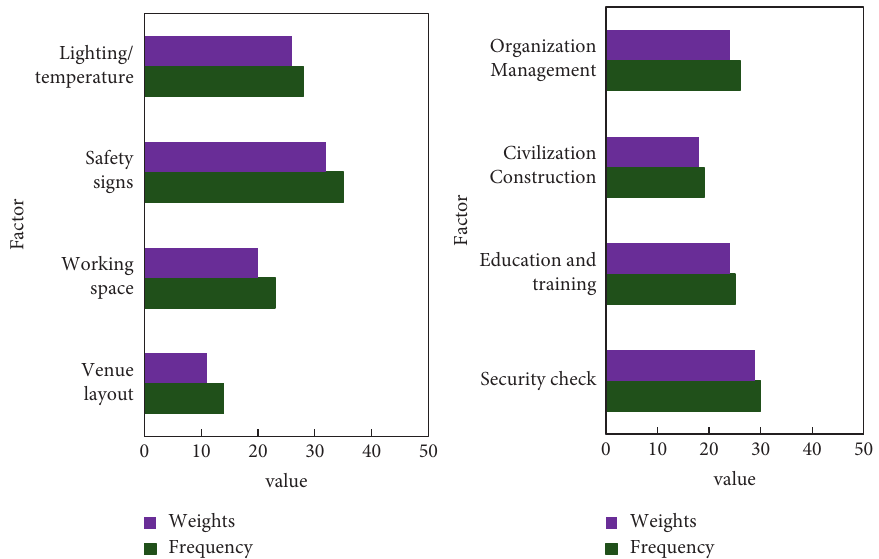
Figure 8: Frequency statistics of environmental management factors.